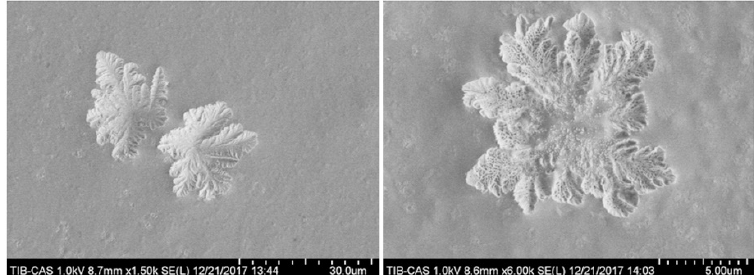
Figure 6. Photomicrographs of polysaccharides as recorded by SEM (these three polysaccharides came from the bamboo shoot shell of Pleioblastus amarus extraction in our